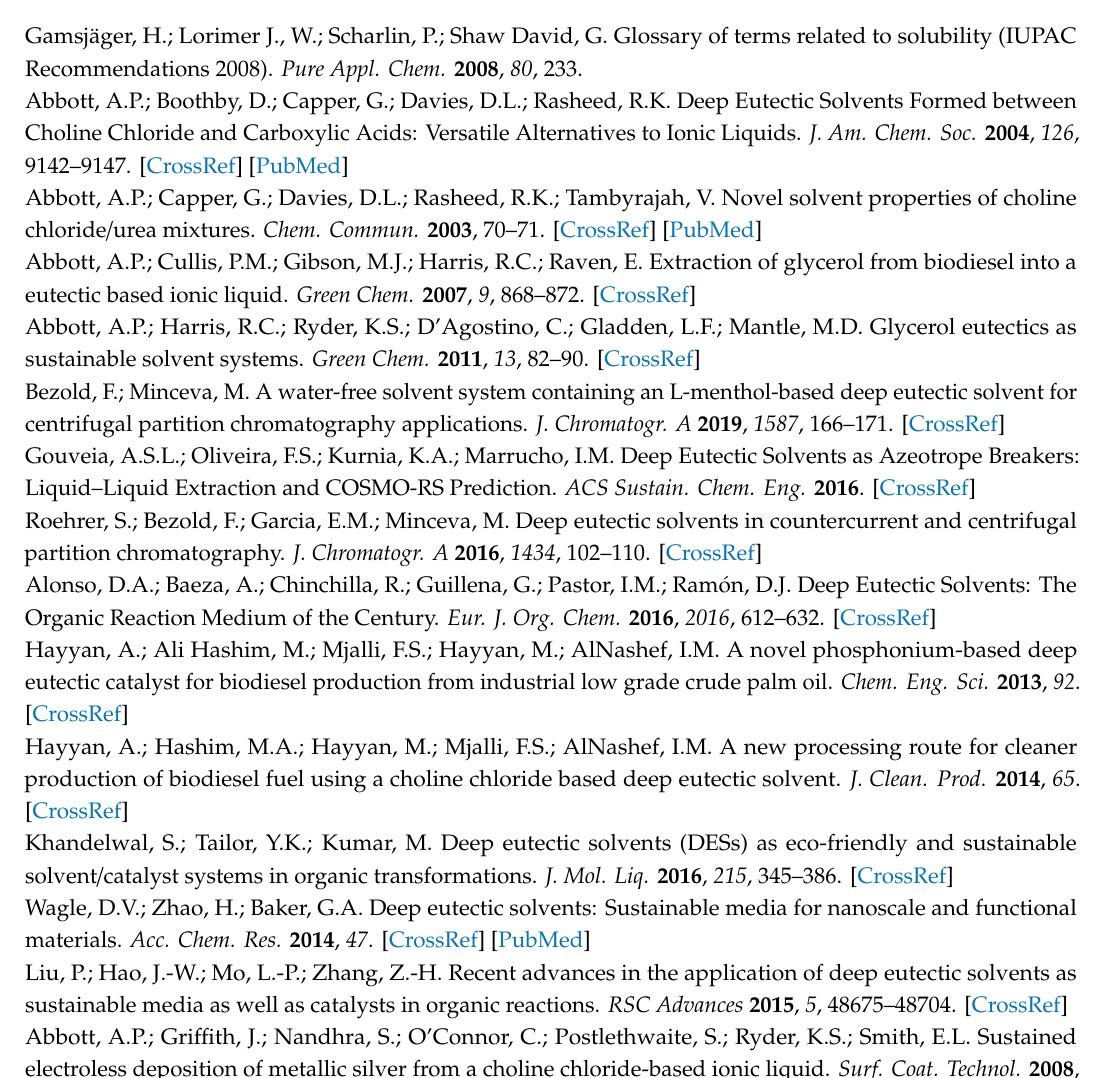
Supplementary Materials: The following are available online. Figure S1. Solid-liquid phase diagrams of binary eutectic systems consisting of l -menthol and ( A ) cyclohexylpropionic acid ( B ) caprylic acid ( C ) cyclohexanecarboxylic acid ( D ) capric acid ( E ) phenylpropionic acid ( F ) lauric acid. Dashed lines are ideal liquidus lines of components modeled using the Schöder-van-Laar equation and using experimental melting properties. Figure S2. DSC curves of l -menthol / 3-cyclohexylpropionic acid and l -menthol / caprylic acid systems. Figure S3. DSC curves of l -menthol / cyclohexanecarboxylic acid and l -menthol / capric acid systems. Figure S4. DSC curves of l -menthol / 3-phenylpropionic acid and l -menthol / lauric acid